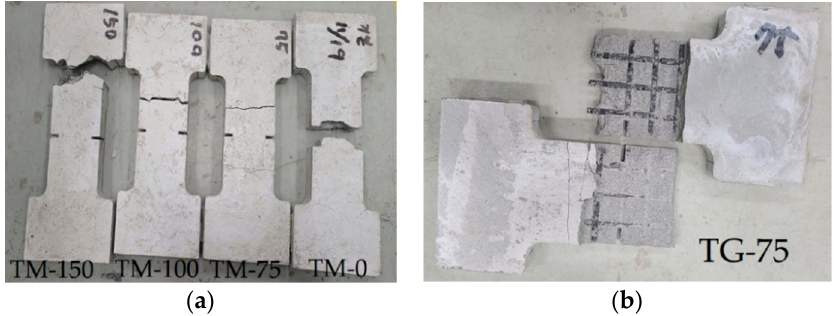
Figure 8. Failure modes of the tensile tested specimens. ( a ) TM series; ( b ) TG-75.